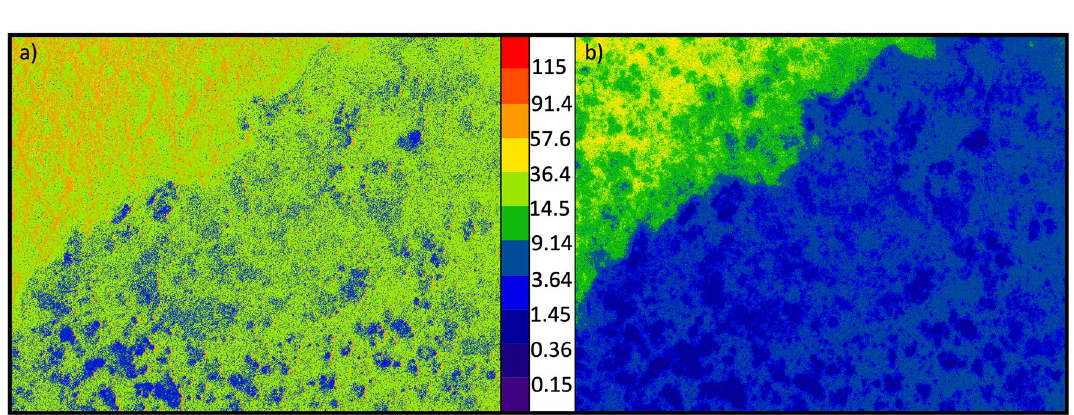
Figure 3. How the emission from different spatial regions responds to changes in incident power. ( a ) shows the excitation intensity difference at which there is the greatest relative increase in emission intensity. ( b ) shows the ‘switch-on’ intensity, i.e. the excitation power at which the emission intensity exceeds the background level. The colour scale indicates the incident power